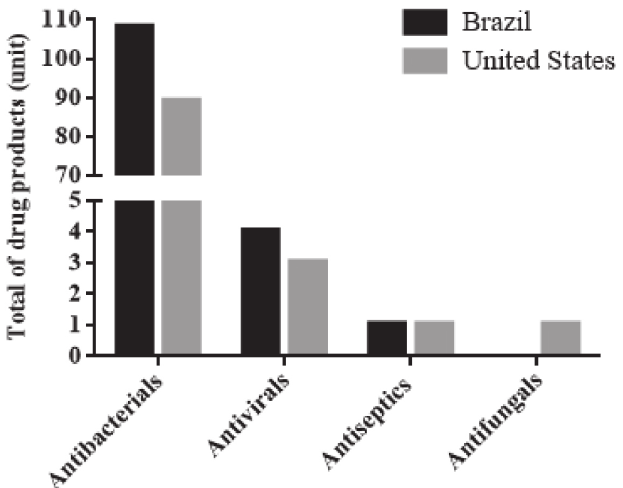
FIGURE 1 - Pharmacological groups registered for ophthalmic products in Brazil and in the United